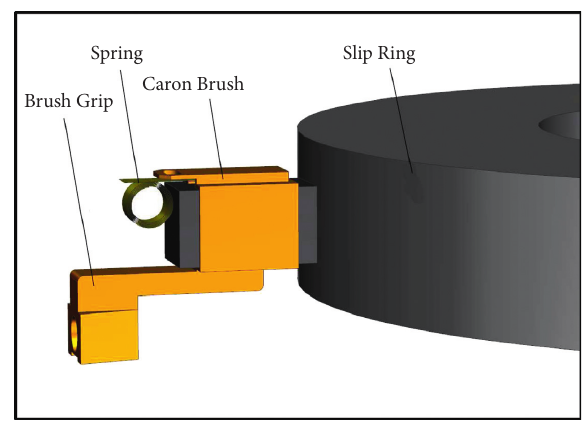
Figure 1: Schematic diagram of the carbon brush/slip ring